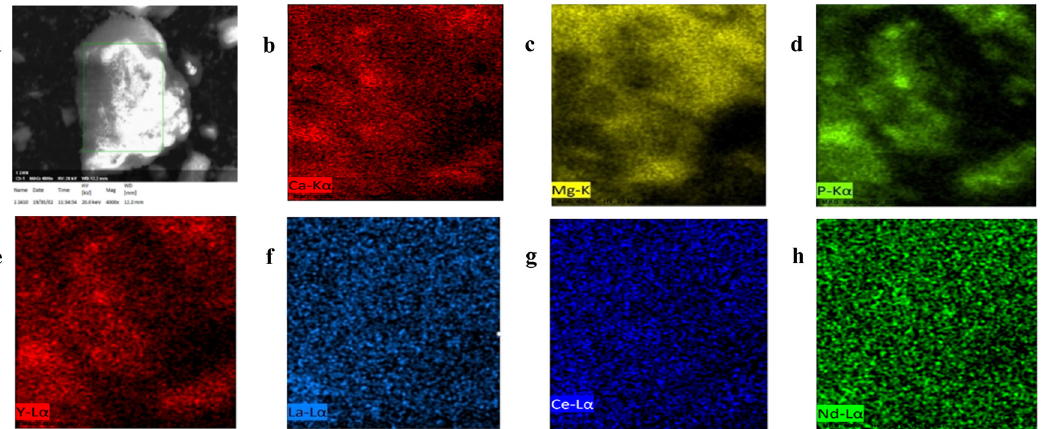
Figure 2: SEM - EDS image of a dolomite particle from which EDS elemental maps were obtained; ( a ) was a SEM image for dolomite particle; ( b – h ) were elemental maps for Ca, Mg, P, Y, La, Ce, and Nd,